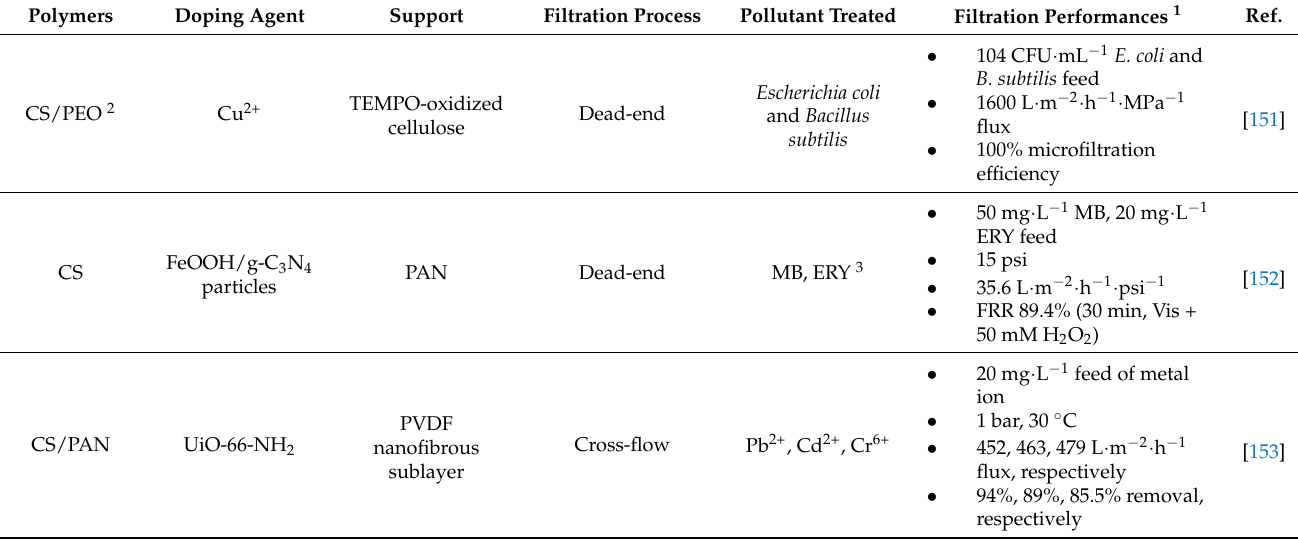
Table 5. Explicative table with reported a comparison of the most recent developed sustainable and functional nanofiber-based filtration membranes.